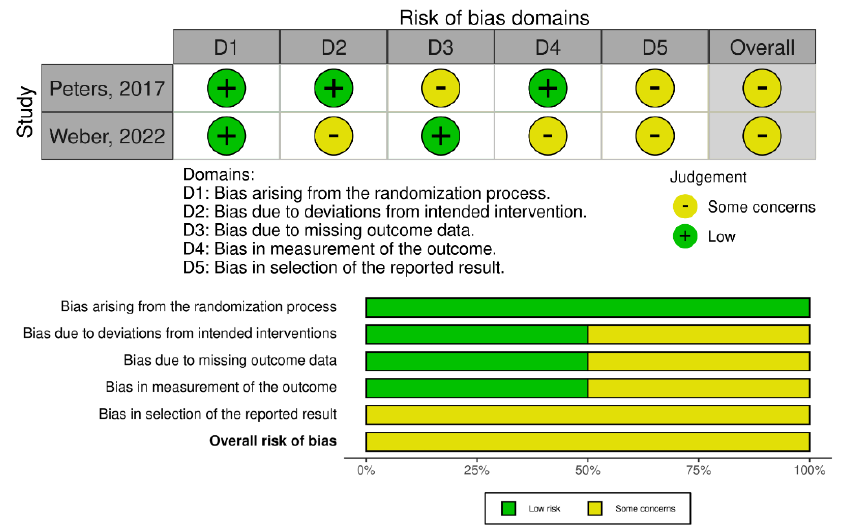
Figure 2. The overall risk of bias assessment using the revised Cochrane risk-of-bias tool [28,31].